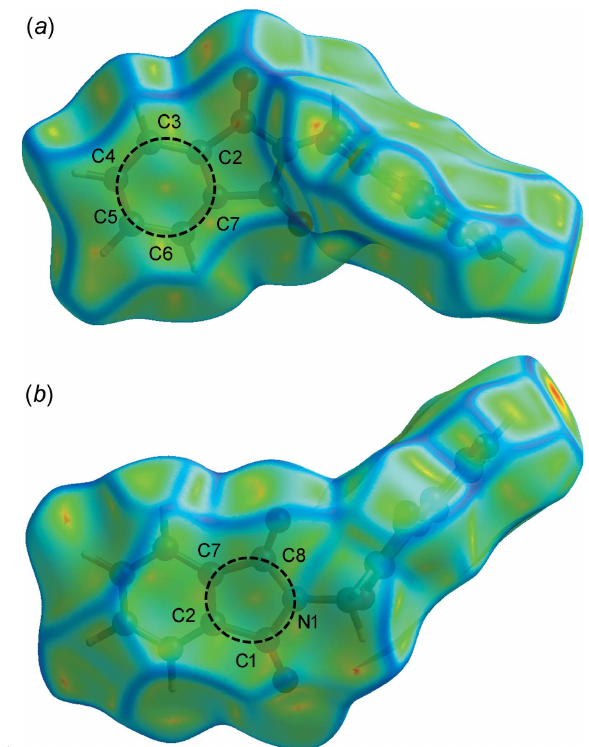
Figure 7 The Hirshfeld surface mapped over curvedness for 1 (cid:3)